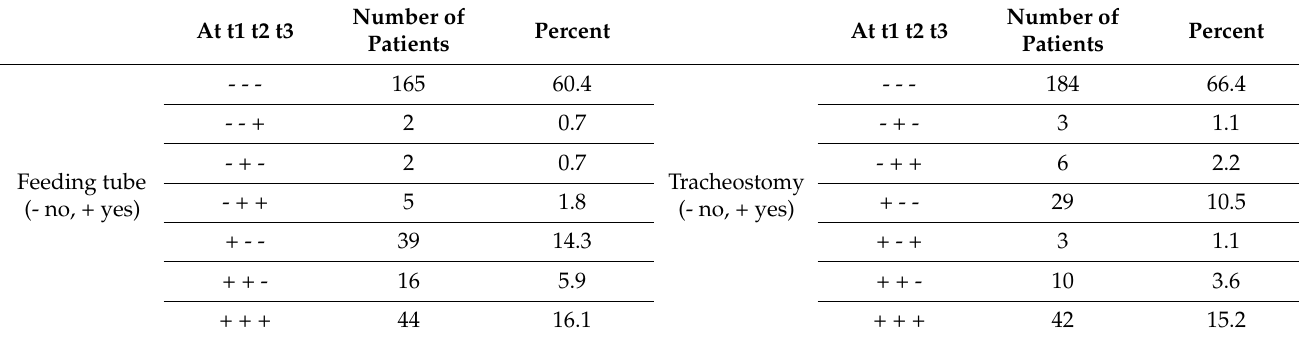
Table 6. Presence of feeding tube and tracheostomy at t1–t3; - no, +